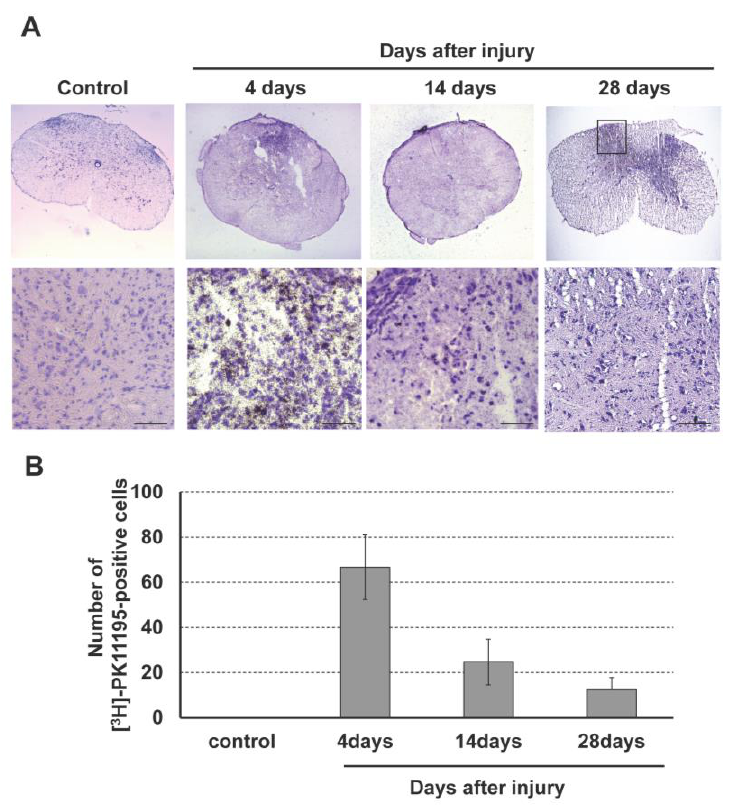
Figure 4. ( A ) (R) -[ 3 H]PK11195 autoradiography in the rat spinal cord injury model. ( B ) Accumulation of (R) -[ 3 H]PK11195 peaked at 4 days after SCI and then gradually decreased in the dorsal horn of the injured spinal cord. Scale bars = 100 μm.